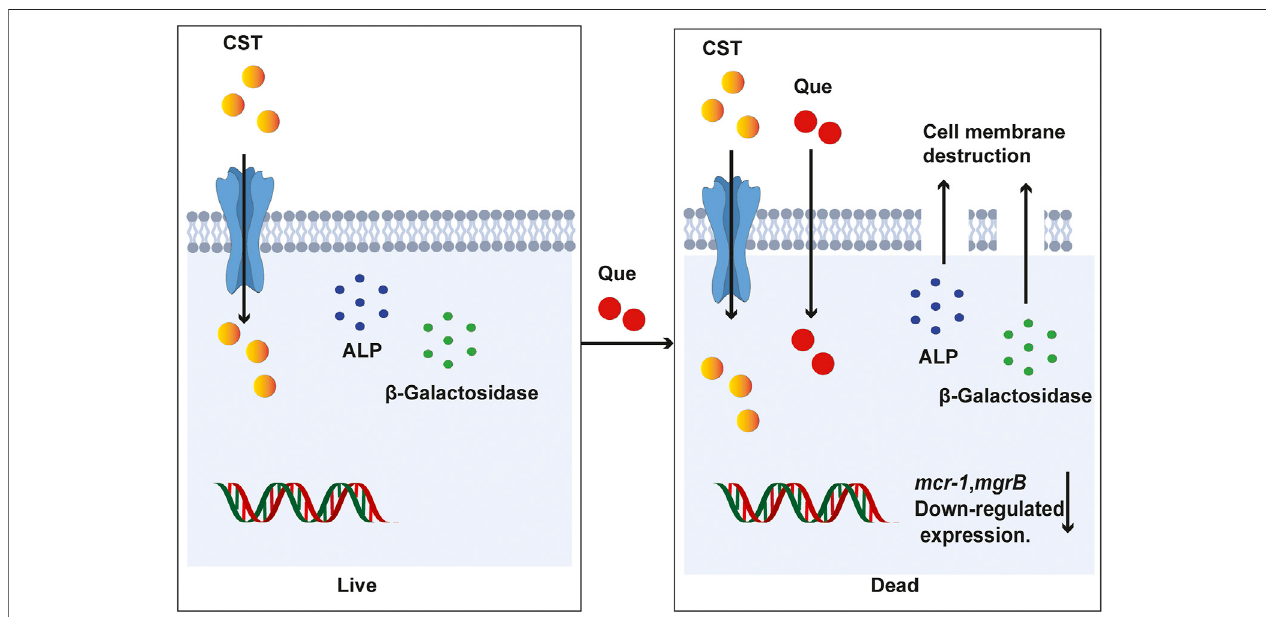
FIGURE 7 | A proposed mechanism of quercetin/colistin combination in eradicating colistin-resistant E. coli and K. pneumoniae .